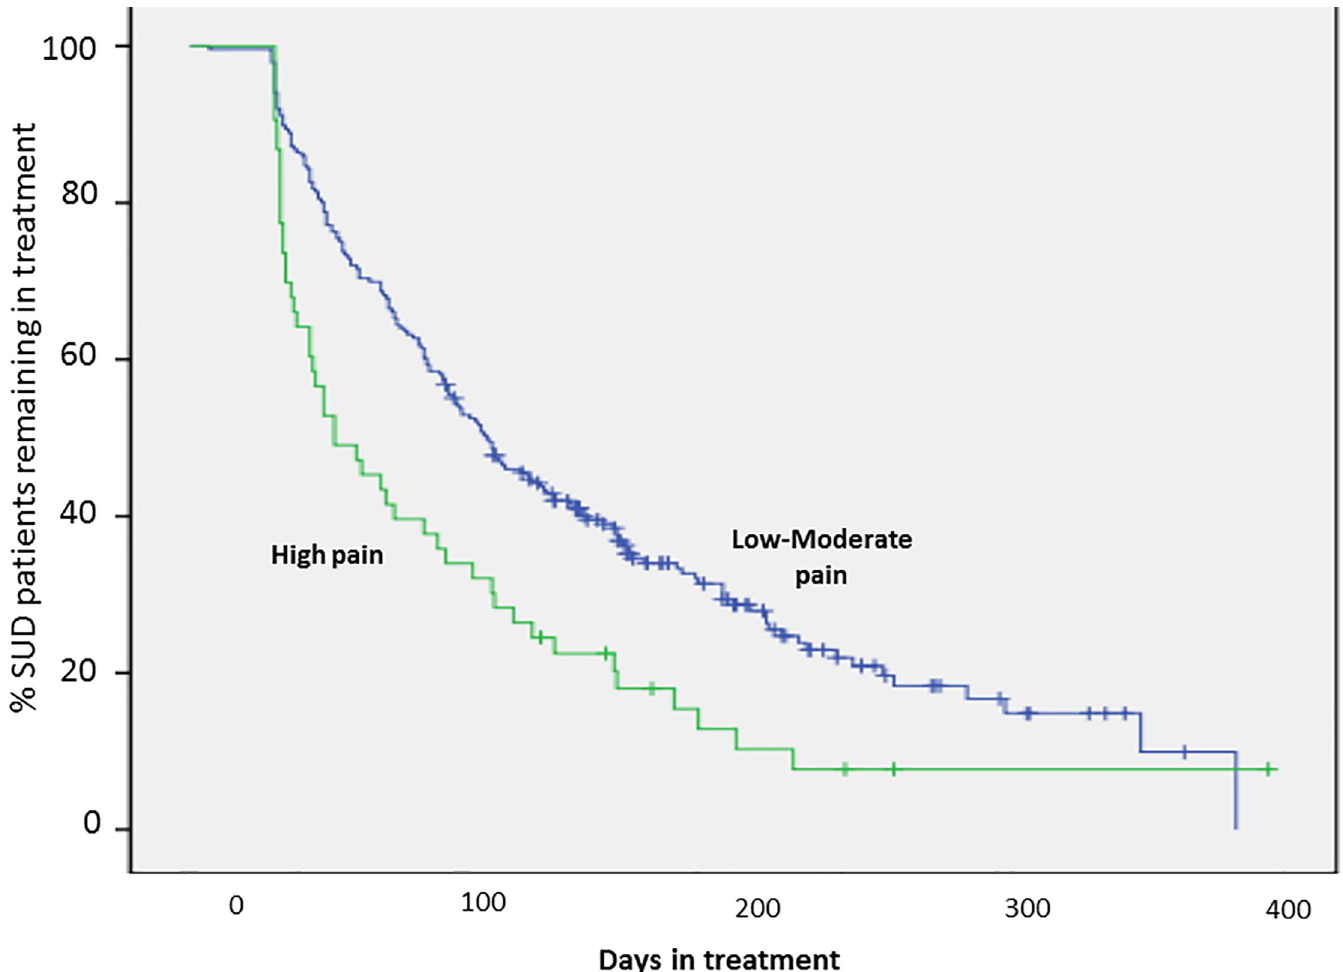
Fig 1. Treatment retention (Kaplan-Meier survival) curves illustrated for SUD patients categorized as High or Low-moderate by psychological pain assessment at program admission.